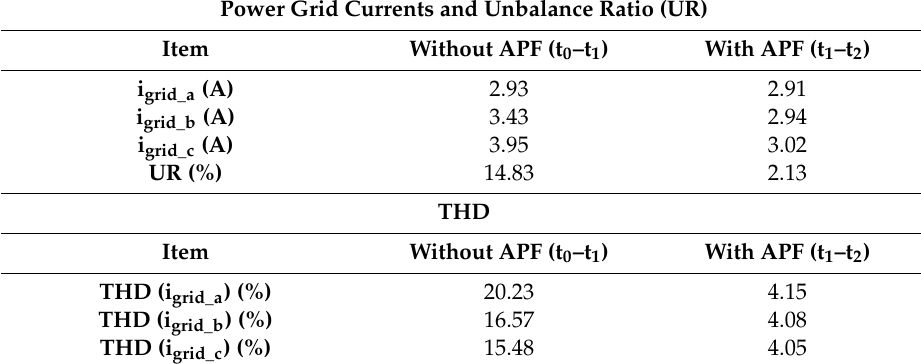
Table 4. RMS currents and THD.